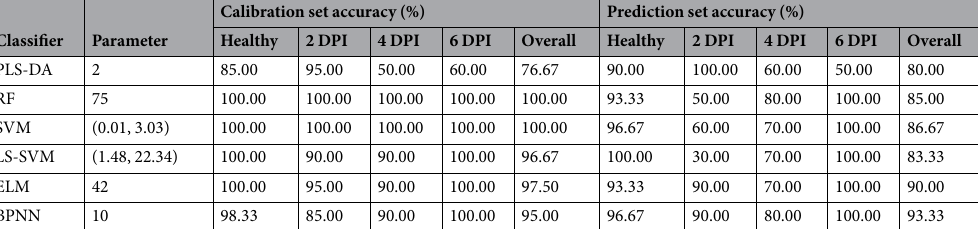
the results showed that both spectral information and texture features could detect and evaluate the stage of dis- eased development. Data fusion is a combination of spectral data and texture variables, which has been proposed in previous literatures and mostly used in food safety and inspection 21–24 . As detailed in Table 3, the prediction performances of different machine-learning models upon data fusion were summarized. PLS-DA model was built with the combined data as X and the category values as Y adopting the leave-one-out cross validation. The threshold value of the PLS-DA model was set equal to 0.5. The optimal number of latent variables (LVs) was determined by the minimum Y residual variance. The classification accuracies of the train- ing set and the test set were 81.67% and 81.67% with 2 LVs. For BPNN model, the learning rate was 0.1 and the iteration epochs were 1000. The number of neurons of the hidden layer was set from 3 to 10. After comparing the performances of BPNN models with different number of neurons in the hidden layer, the optimal number was determined as 6 with a success rate of 95.00%. The number of nodes in the hidden layer was influential within ELM models. The optimal number of nodes in the hidden layer was based upon a stepwise search. The number of nodes was selected from 1 to 120 with a step of 1. The optimal result was obtained by 60 nodes in the hidden layer. For RF model, the number of trees in the forest was set from 50 to 200, and the number of features to be used for each node was 5. The optimal number of trees was determined by the performances of RF models. The optimal parameter of forest trees was 62 with the accuracies of the training set and the test set up to 100.00% and 93.33% separately. With regard to SVM model, the optimal penalty coefficient (C) and the kernel function parameter gamma (g) were obtained by a grid-search procedure in the range of 2 − 8 –2 8 with the kernel function of RBF. In terms of LS-SVM model, it was noticeable that radial basis function (RBF) kernel was recommended as the kernel function of LS-SVM, since RBF could handle the nonlinear relationships between the spectra and target attributes and give a good performance under general smoothness assumptions. In addition, to achieve the optimal combination of ( γ , σ 2 ) and avoid overfitting problems, a two-step grid search technique was employed with the leave-one-out cross-validation. The ranges of γ and σ 2 within 10 − 2 –10 5 were set based on experience and previous researches by our team 25, 26 . The optimal model parameters ( γ , σ 2 ) were achieved with (33.52, 9.88) based upon the EWs. The performances of different machine-learning algorithms with combined datasets obtained better results with their classification accuracies of calibration and prediction all above 80% than those only using EWs or texture features (Fig. 4). Although the highest classification rate was not improved but lowered, we believed that this phenomenon was normal because the prediction mechanisms of the classifiers were different. From the per- spective of machine learning, when the feature increases, the classification accuracy does not necessarily increase. When combining spectra data and textural features, the BPNN and ELM classifiers might be involved part of noise into the network during their training phase. From our analysis, data fusion overally improved the classi- fication accuracies and received better results by taking advantages of spatial and spectral information of hyper- spectral images, which is promising and encouraged for further researches. Through the observation of other leaves from the infected tobacco plants, the appearance of visual symptoms was found on the 5th day after inoculation, and the typically systemic symptoms of TMV infection (light and dark green areas, and leaf margin deformity) occurred on the 11th day. Therefore, hyperspectral imaging demon- strated a visible difference between the infected (2 DPI) and non-infected (healthy) leaves in a short period of time (i.e. 48 h) in comparison with the reference images (5 days for visible symptoms of infection, 11 days for